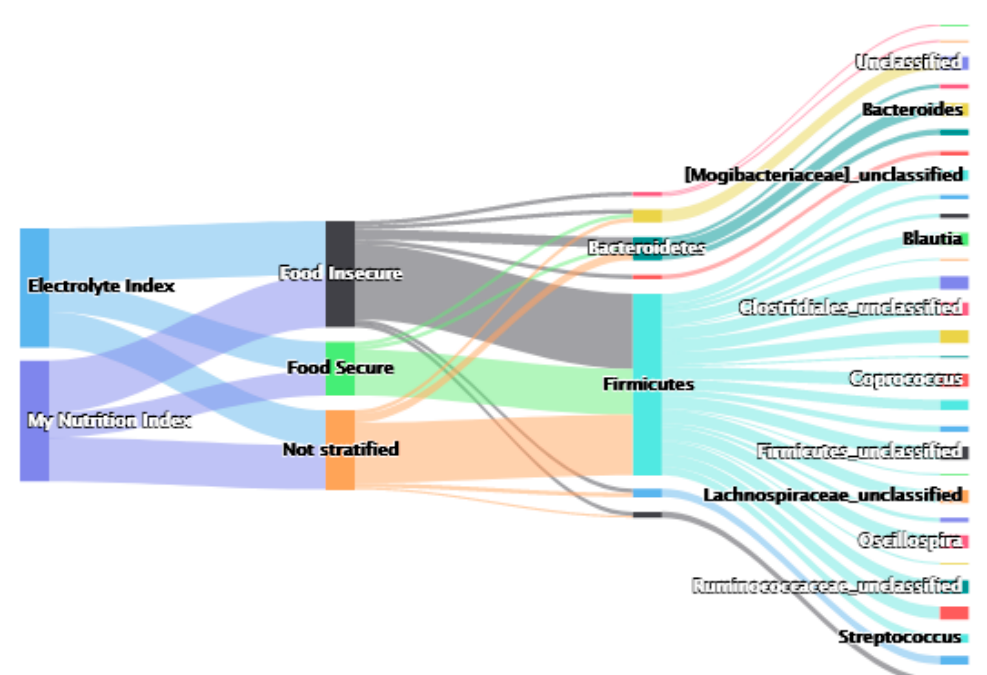
Figure 1. Sankey Plot illustrating the overlap of genera with weights above the threshold (summed OTU weights within genera) from each of the six statistically significant WQS RSRH analyses testing for association between the microbiome mixture and the nutritional indices. The genera represented show that each genus was found to be highly weighted. Nodes, from right to left, display the WQS RSRH analysis outcome (My Nutrition Index/Electrolyte Index), stratification of WQS RSRH weights by food security (not stratified/food secure/food insecure), bacterial phylum, and bacterial genus. The widths of links between nodes are proportional to the number of genera in common to each set of nodes. Scrolling over the links between nodes displays the number of genera found to be above the weight threshold in the WQS RSRH analyses, dependent upon the relationship between the nodes. Click on the link to see the GIF: https://rpubs.com/bixbym/933453.